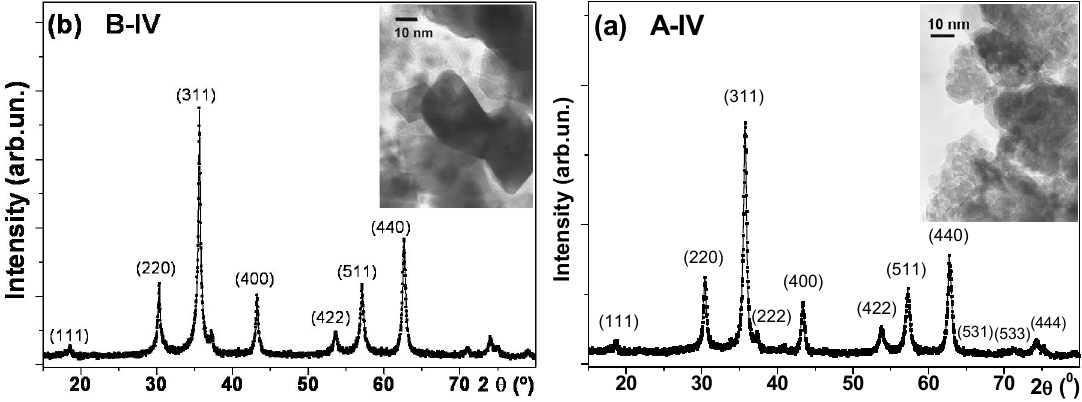
Figure 1. X-Ray diffraction spectra and TEM images for sample A-IV (Zn